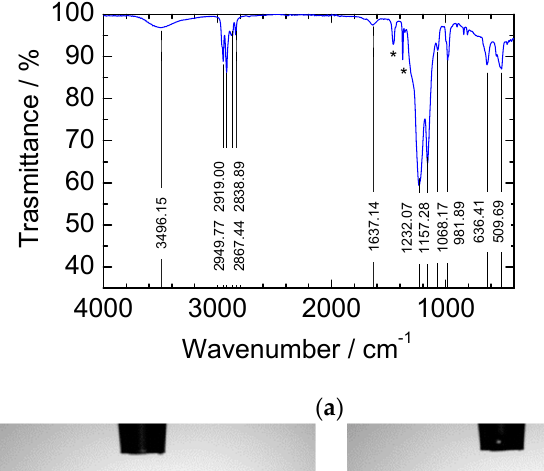
Figure 2. ( a ) FTIR-ATR spectrum of CN01. The peaks indicated by an asterisk are related to the CH 3 bending of C2075 (see also Figure S1). Contact angle of a drop of propylene carbonate after 10 s of the drop fall on ( b ) CN01 and ( c ) C2075.